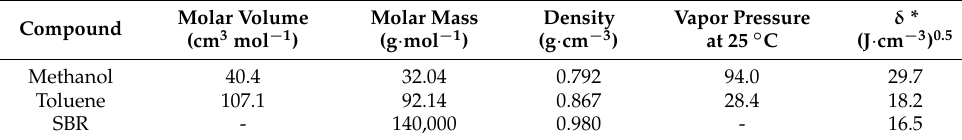
Table 2. Properties of solvent and rubber